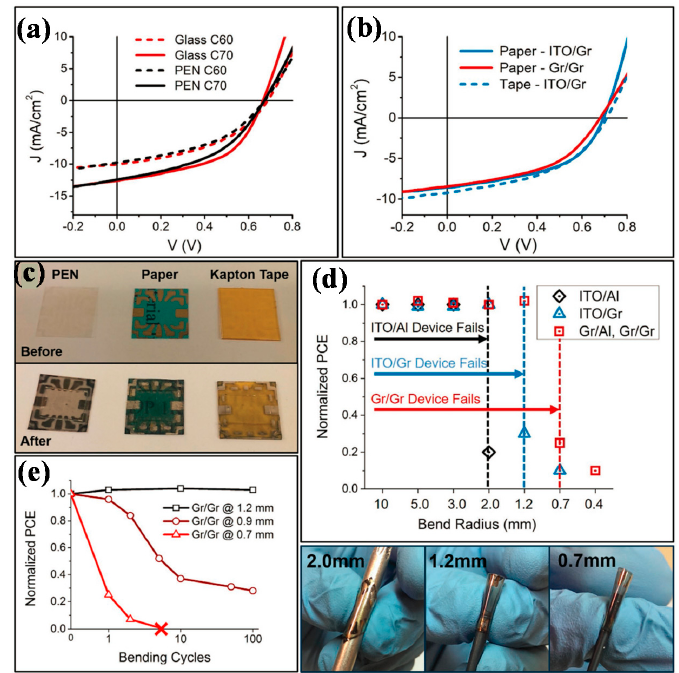
Figure 6. ( a ) Comparison of PC 60 BM and PC 70 BM Gr/Gr devices on rigid glass substrates and on flexible PEN substrates; ( b ) J–V curves of devices on paper and Kapton tape and ( c ) photographs of substrates (PEN, paper, Kapton tape) before and after device fabrication; ( d ) Device performances when bent to different radii of curvature and photographs of a device being bent; ( e ) Normalized PCE of Gr/Gr devices versus number of bending cycles. Reproduced with permission from [59]; published by John Wiley and Sons,